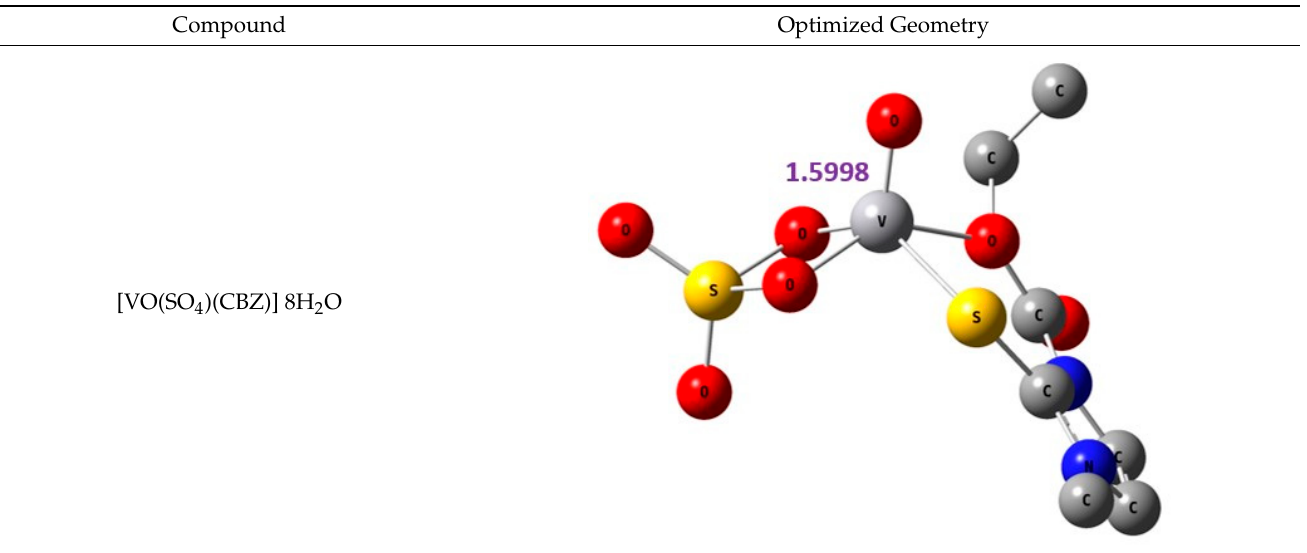
Table 5. The optimized geometry and V=O bond length of the metal complexes in the gas phase using DFT method LANL2DZ basis sets.